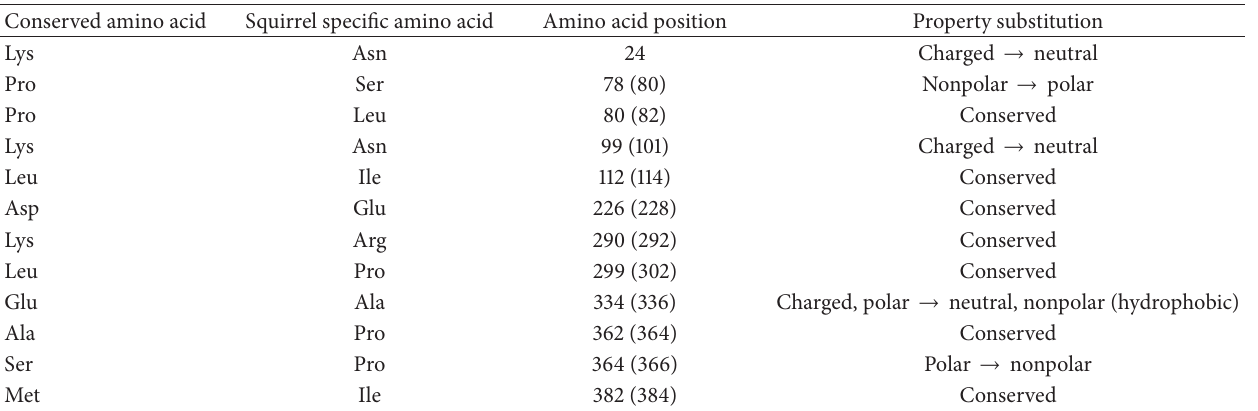
Table 1: Unique substitutions found in the ground squirrel p53 protein sequence at amino acid residues that are conserved in nonhibernating mammals. Bracket indicates amino acid position in